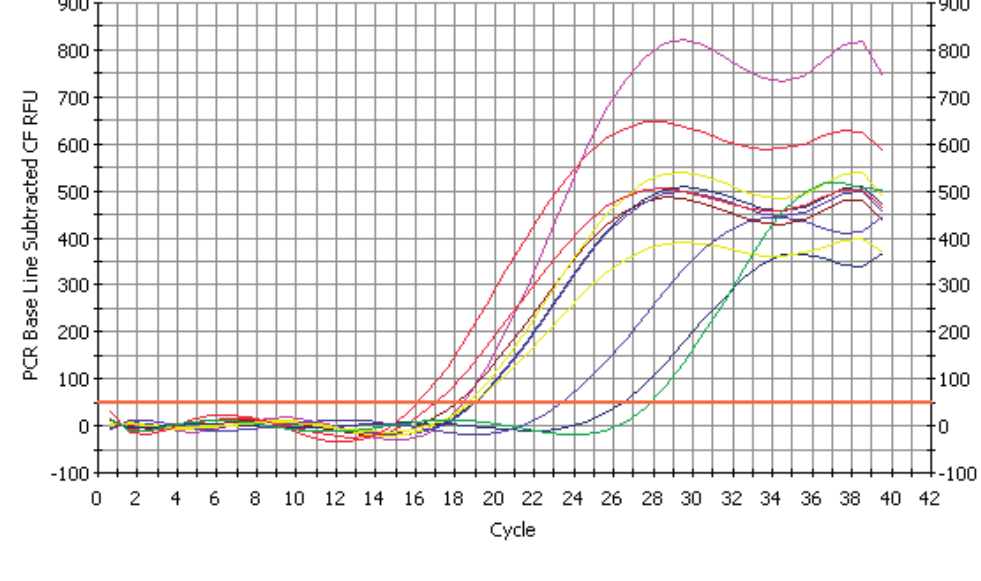
Figure 5. Fluorescence quantitative curve of ICycler. Table 5. Quantitative DNA of